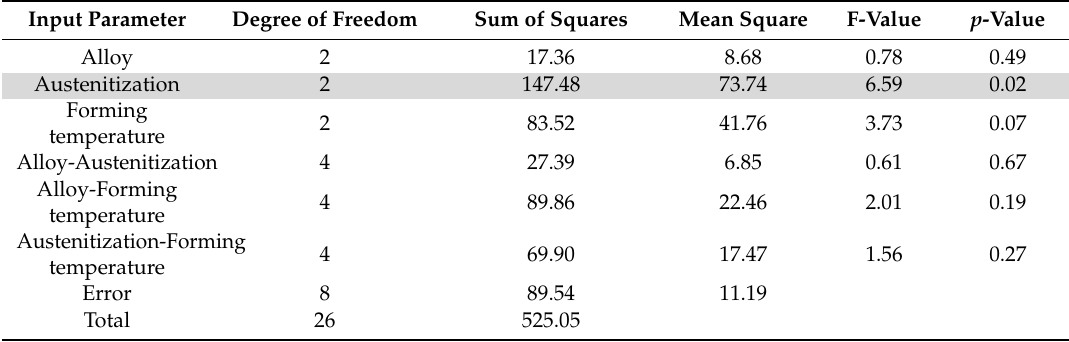
Table 7. ANOVA results for the resulting maximum drawing depth without the input parameter flange